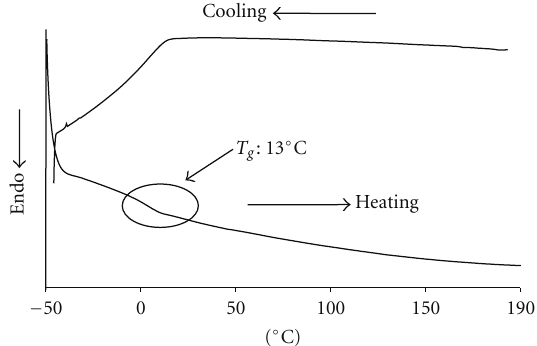
Figure 6: DSC trace of PMAPOSS- b -PMAHFC 2 (from − 50 ◦ C to 190 ◦